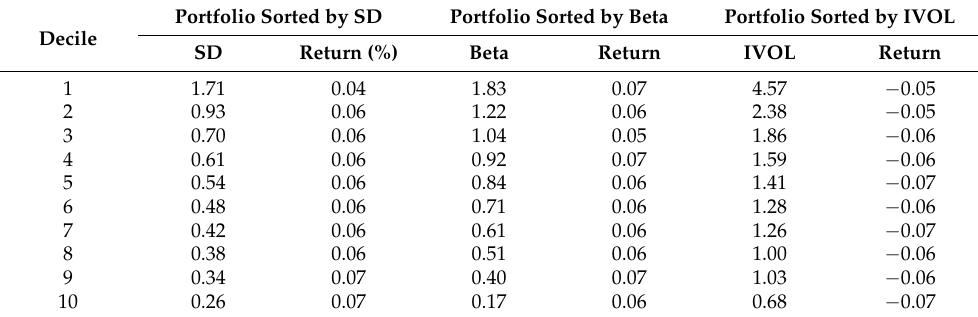
Table 2. Average portfolio returns sorted by standard deviation, beta, and IVOL. Portfolio Sorted by SD Portfolio Sorted by Beta Portfolio Sorted by IVOL Decile SD Return (%) Beta Return IVOL